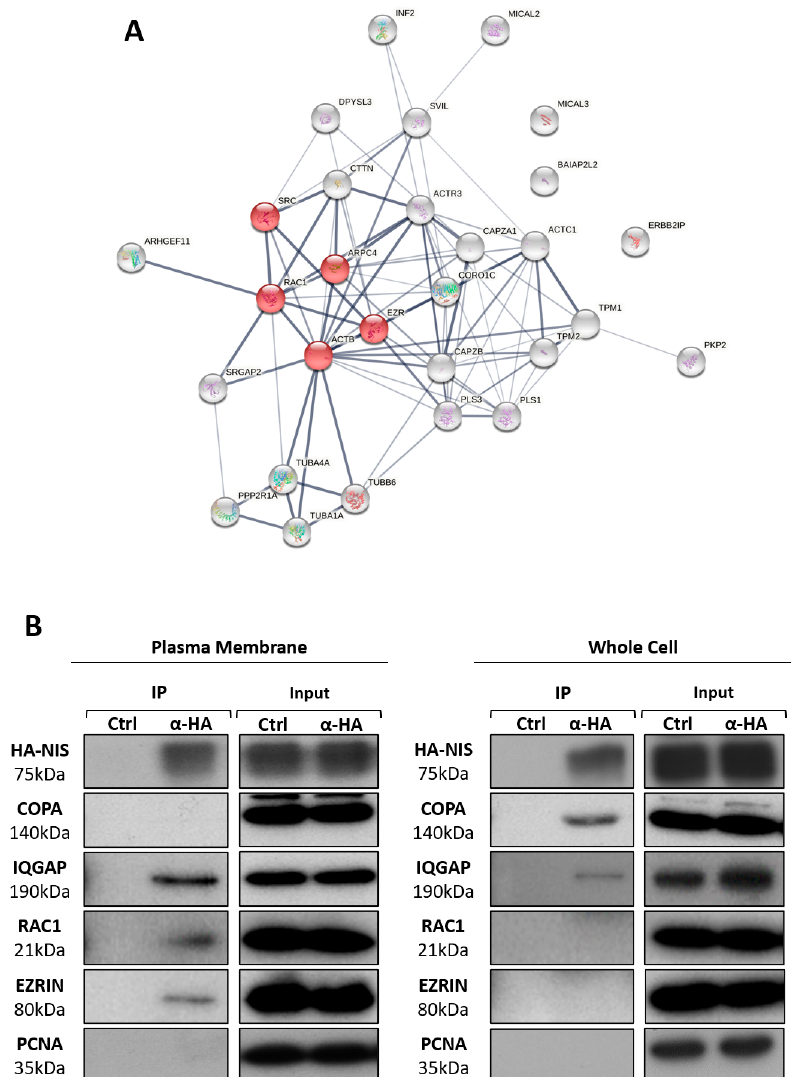
cytoplasmic actin (ACTB) and four of the regulatory proteins on the hsa04810 pathway (Figure 3A): the small GTPase RAC1 (RAS-related C3 botulinum toxin substrate 1), the proto-oncogene tyrosine-protein kinase Src (SRC), the actin-nucleating ARP 2/3 complex Cancers 2021 , 13 , x FOR PEER REVIEW subunit 4 (ARPC4), and the actin-binding adaptor protein ezrin (EZRIN).